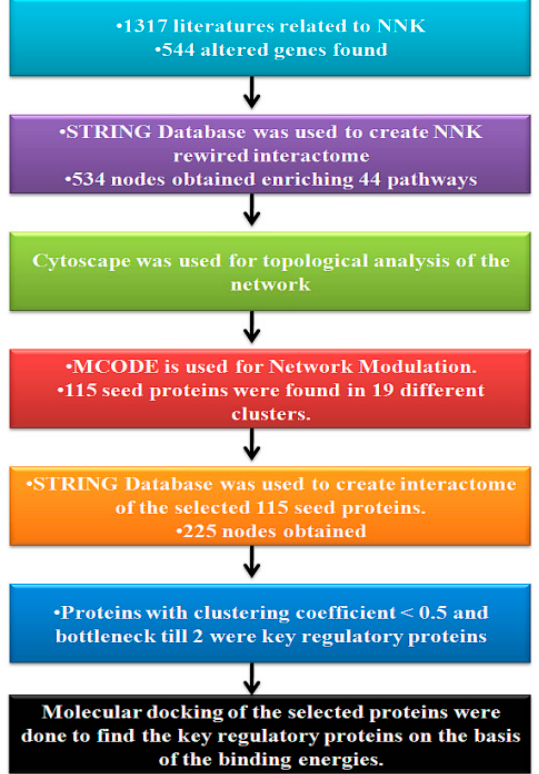
Figure 1. Schematic diagram of the adopted methodology.